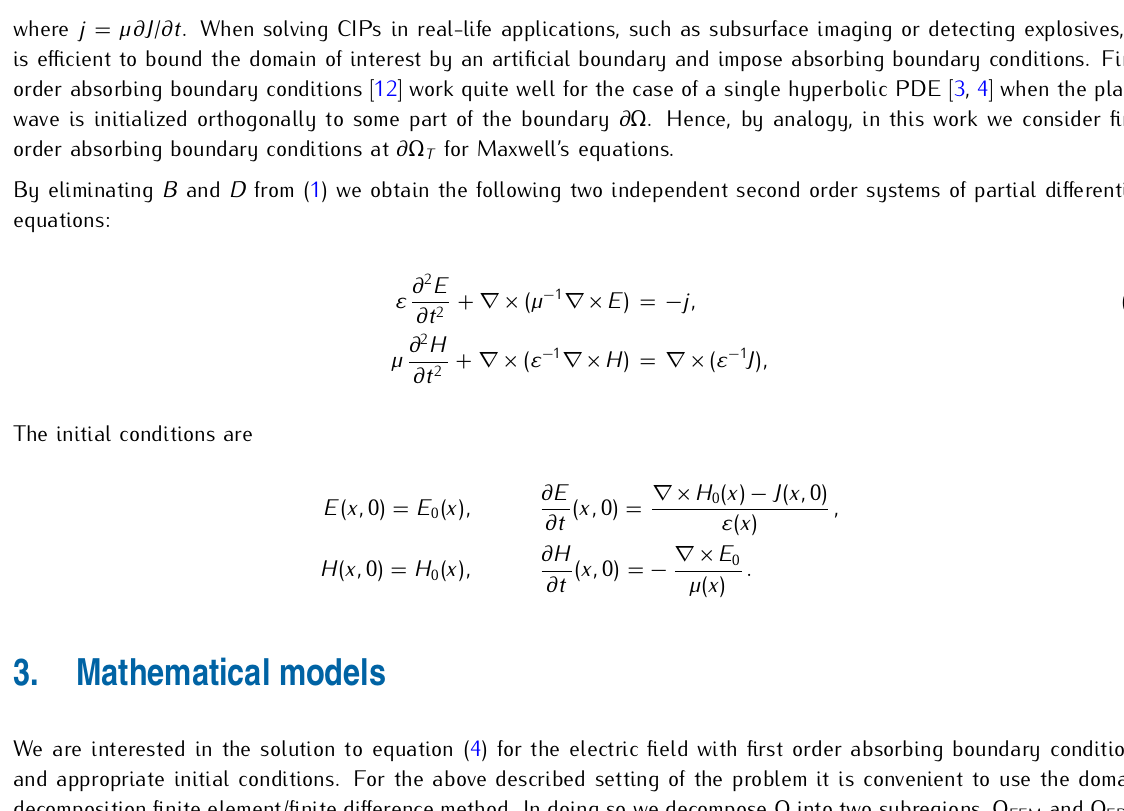
, while simultaneously the solution obtained in Ω FEM